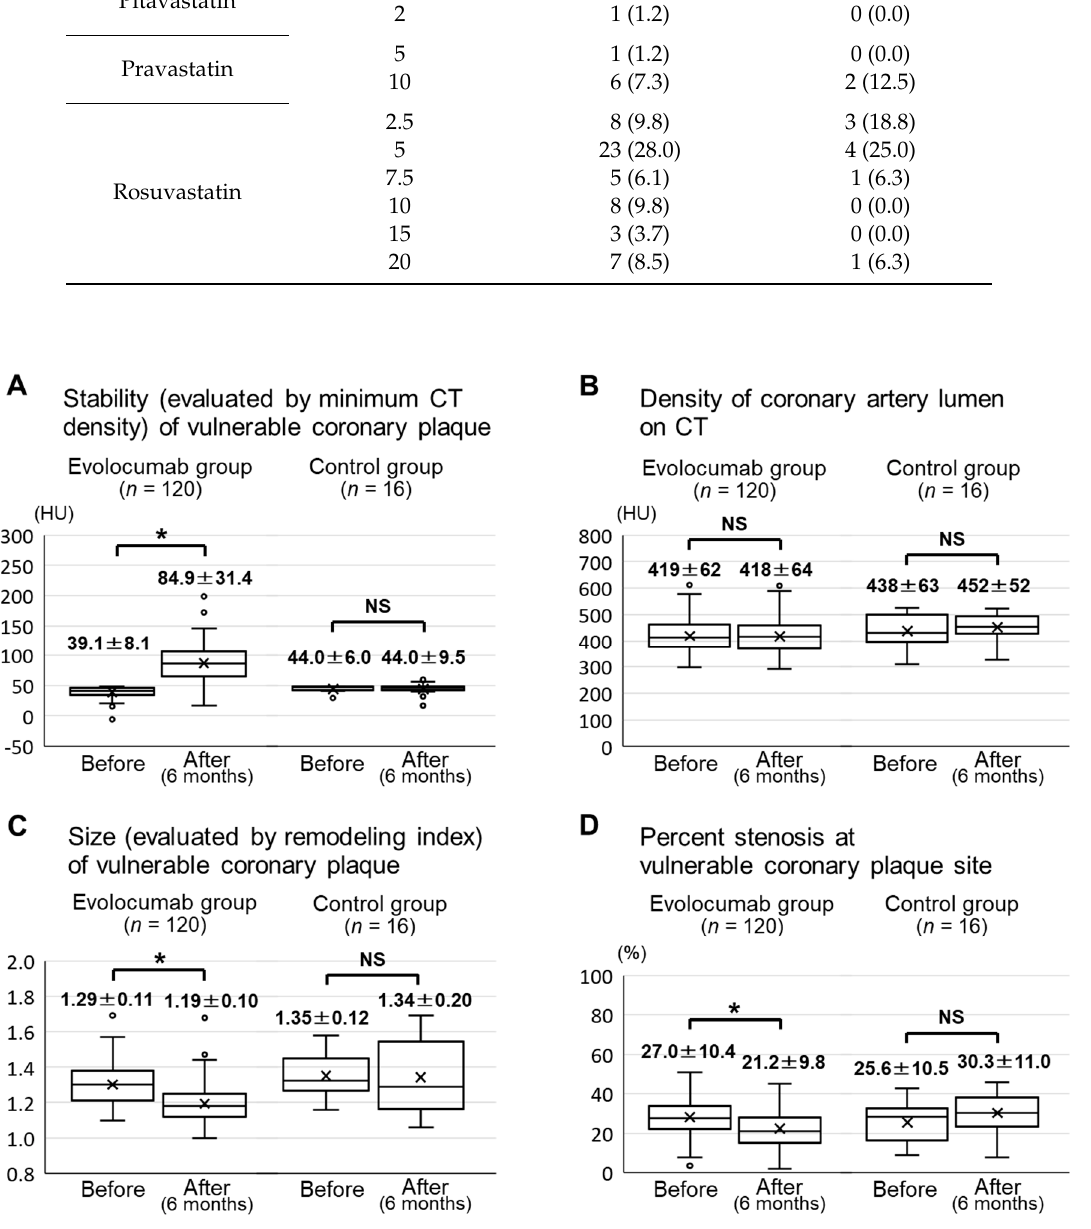
Figure 4. CT angiography parameters before and six months after the baseline in the evolocumab and control groups. Minimum CT densities of the vulnerable coronary plaques ( A ). CT densities of the coronary artery lumen ( B ). Remodeling indexes of the vulnerable coronary plaques ( C ). Percent stenosis at vulnerable coronary plaque sites ( D ). Abbreviations: CT, computed tomography; NS, not significant. * p < 0.001.